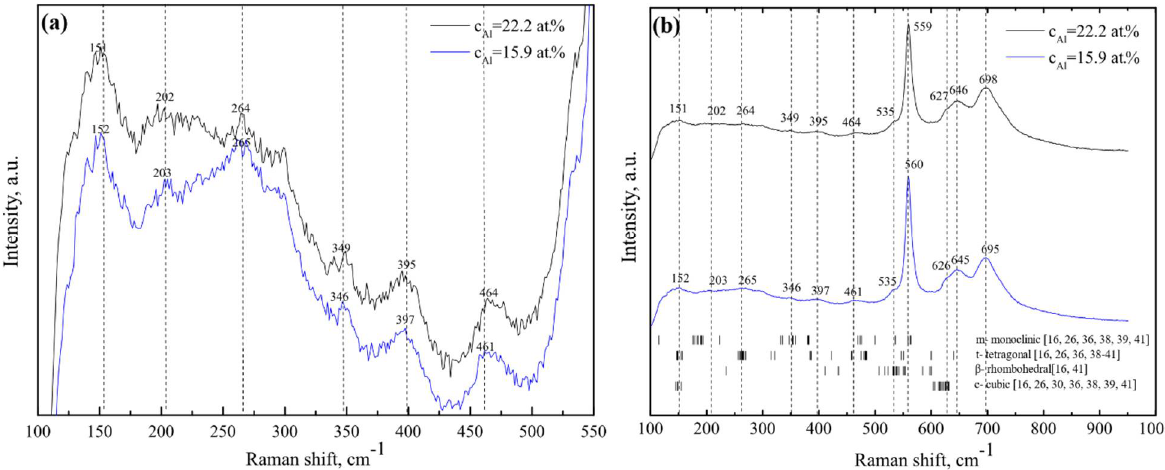
Figure 7. Raman spectra measurements of 6ScAlSZ thin ceramic films deposited on Alloy600 in annealing process (30–900 °C) containing 15.9 and 22.2 at.% of Al: ( a ) range of 100 to 550 cm −1 and ( b ) range of 100 to 900 cm −1 .